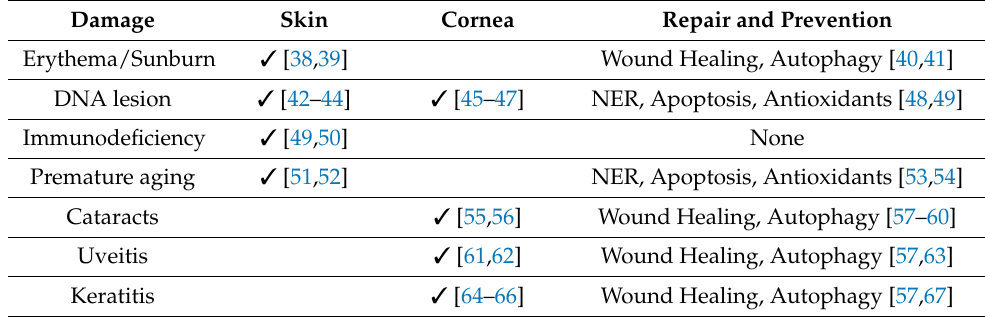
Table 1. UV damage and repair mechanisms in both skin and